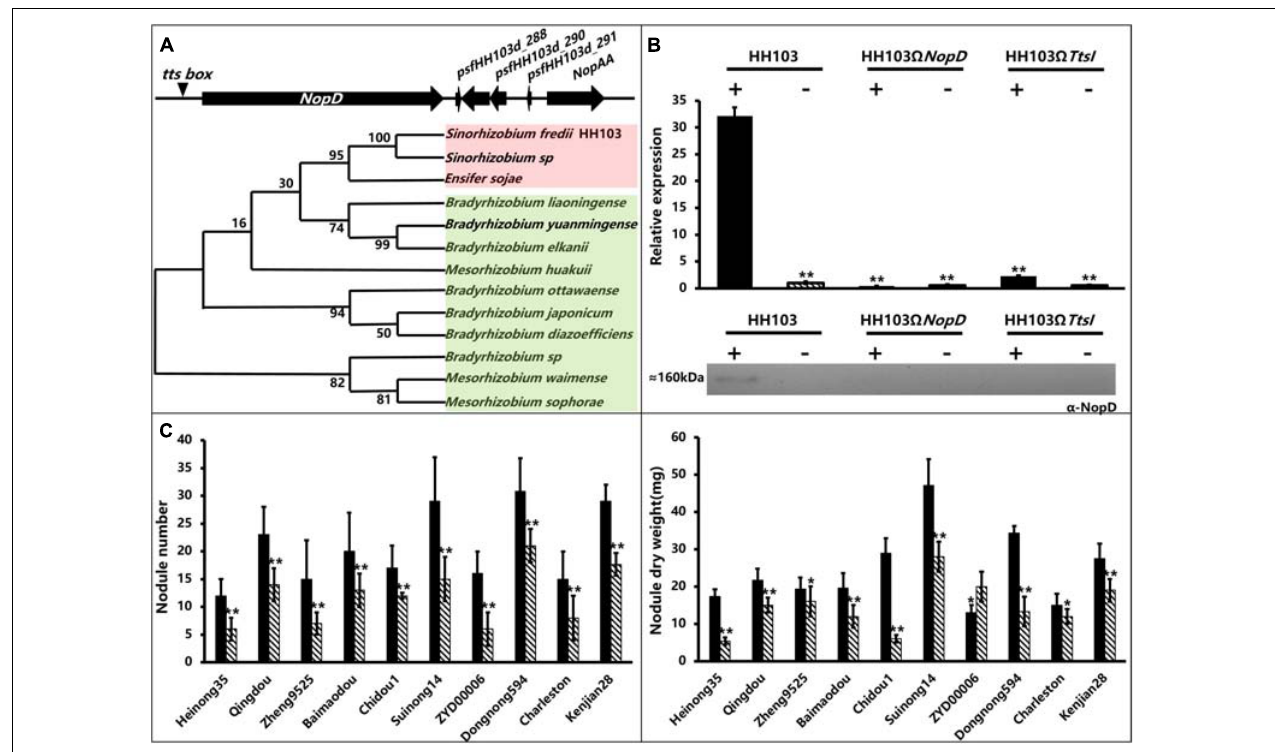
FIGURE 1 | The information of NopD gene, detection of NopD protein induction by genistein and nodule traits of soybean plants inoculated with S. fredii wild-type HH103 or mutants HH103 (cid:127) NopD and HH103 (cid:127) TtsI. (A) Position of the NopD gene and phylogenetic tree of NopD from various rhizobial strains by neighbor-joining method using MEGA6.0 software. (B) Expression analysis of NopD in S. fredii wild-type strain HH103 and mutants HH103 (cid:127) NopD and HH103 (cid:127) TtsI with (+) or without ( − ) genistein (3.7 µ M). Final expression was calculated relative to the expression of the wild-type strain HH103 in the absence of genistein. All sample harvests were performed with three biological replicates, and the individual values for each RNA sample were analyzed by three technical replications. The sample of the wild-type strain S. fredii HH103 in the absence of genistein was used as the control. Asterisks indicate significant differences at the level α = 1% ( P < 0.01). Immunoblot analysis of NopD in extracellular protein extracts of the wild-type strain S. fredii HH103 and indicated mutant derivatives induced with or without genistein (3.7 µ M). Immunoblots were performed with anti-NopD antibodies. (C) The analysis of phenotype was performed three times; significant differences were determined by t -tests; * indicates 0.01 ≤ P ≤ 0.05 and **indicates P ≤ 0.01. Soybean varieties (with origins): Heinong35 (Heilongjiang), Qingdou (Shanxi), Zheng9525 (Henan), Baimaodou (Zhejiang), Chidou1 (Inner Mongolia), Suinong14 (Heilongjiang), ZYD00006 (Heilongjiang), Charleston (America), Dongnong594 (Heilongjiang), Kenjian28